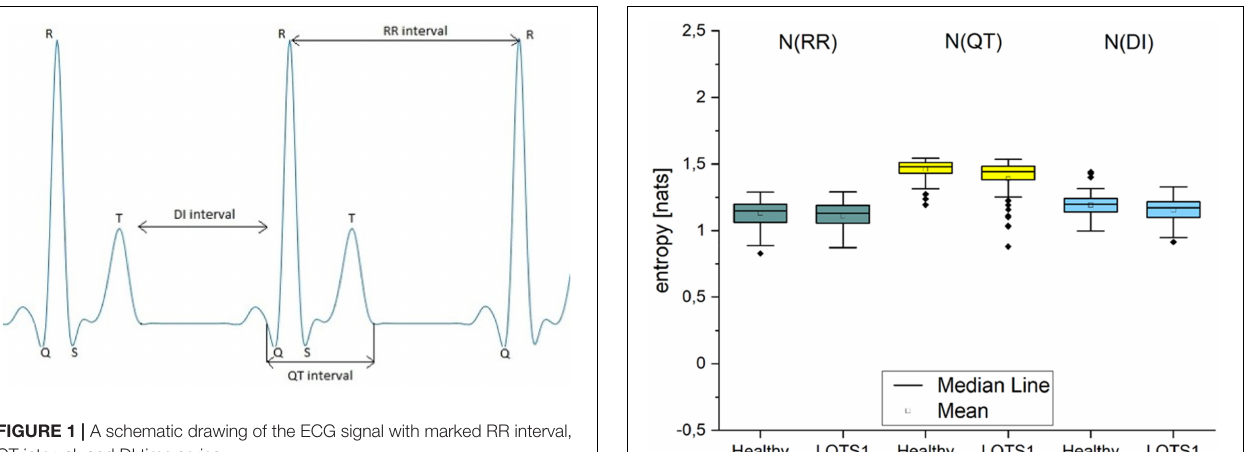
FIGURE 1 | A schematic drawing of the ECG signal with marked RR interval, QT interval, and DI time series.